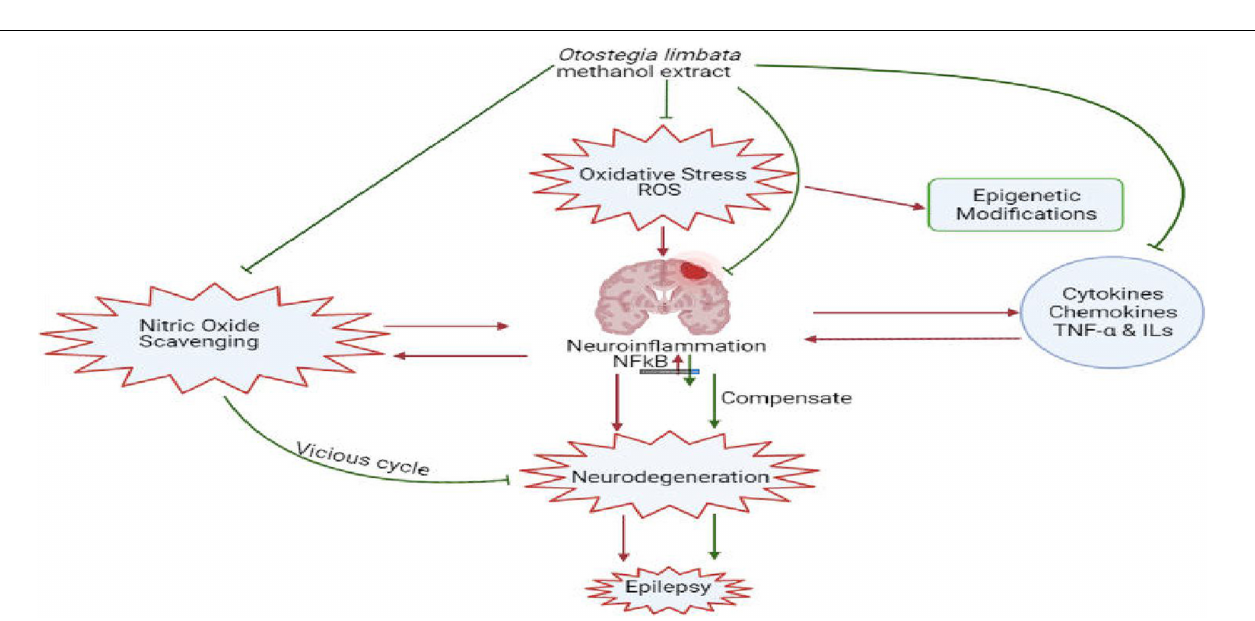
FIGURE 10 | Diagrammatic representation of the role of oxidative stress and neuro inflammation in generating epilepsy and antioxidant and neuroprotective potential of limbata in suppression of inflammatory cytokines and down regulation of